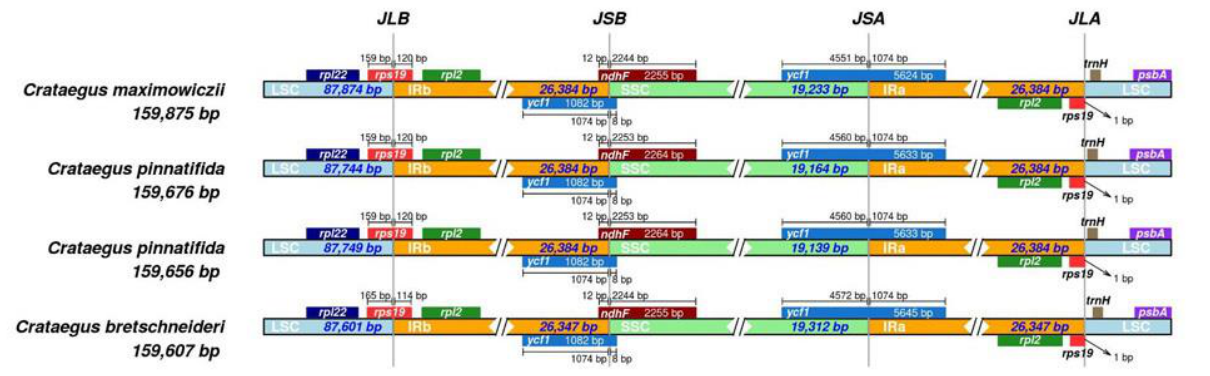
Figure 2. Comparison of the LSC, IR, and SSC borders among the four Crataegus plastomes..